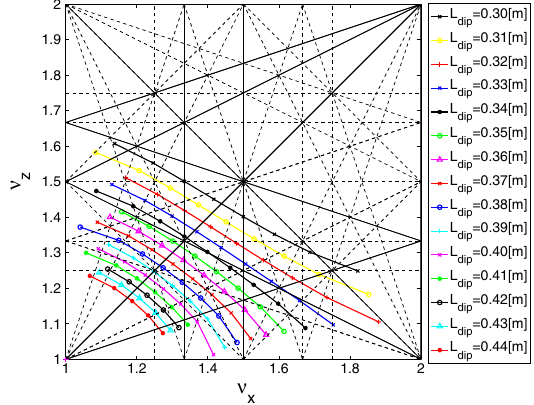
FIG. 1. Tune diagram for various lengths and edge angles of dipole magnets. The bare lattice consists of four dipoles with edge angles. Each curve (same color and symbol) corresponds to dipole length from 0.31 to 0.44 m, respectively. On each curve, different data points correspond to different edge angles of the same dipole length, where the edge angle varies by an increment of